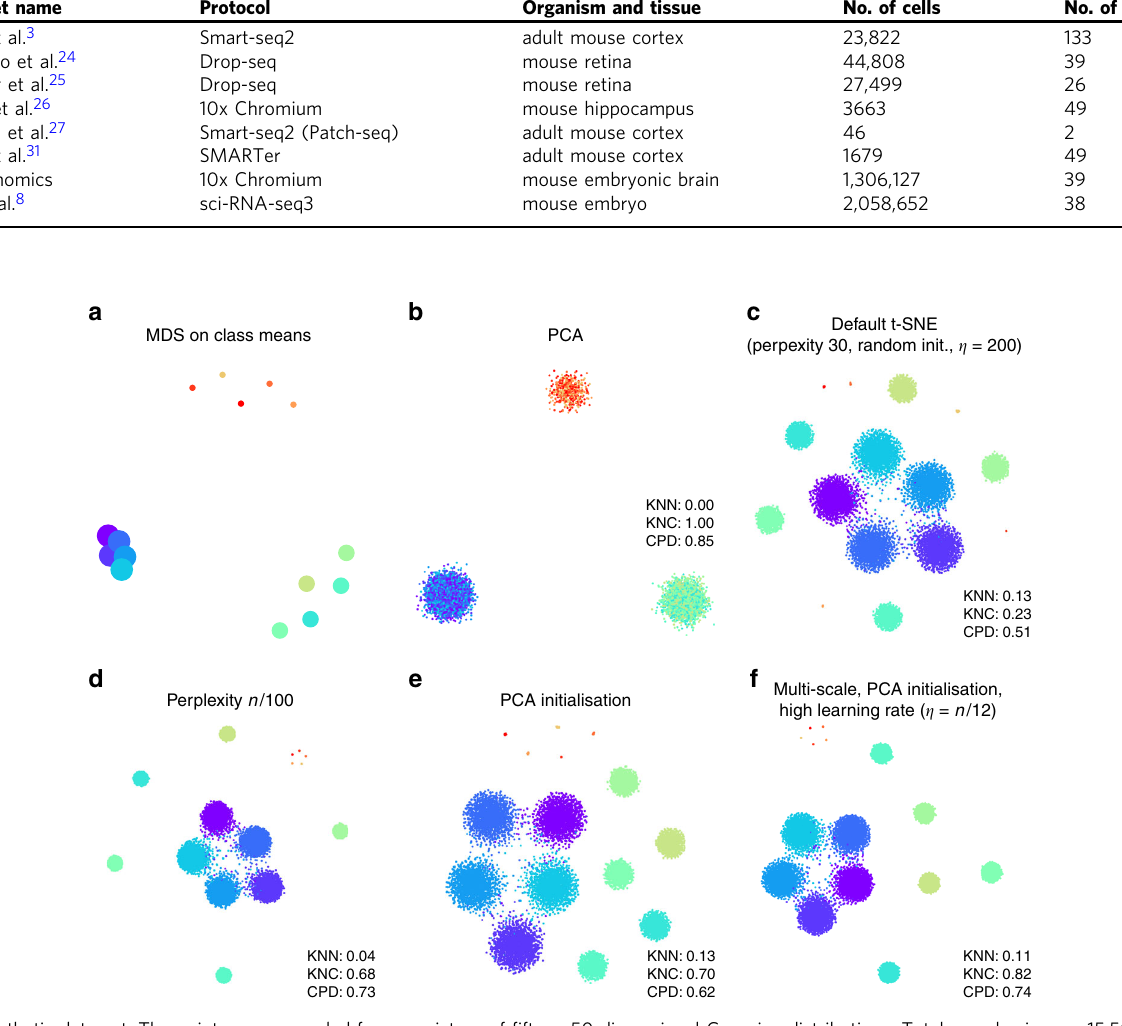
Fig. 1 Synthetic data set. The points were sampled from a mixture of fi fteen 50-dimensional Gaussian distributions. Total sample size n = 15,500. a Multidimensional scaling of 15 class means. Point sizes are proportional to the number of points per class. b The fi rst two principal components of the data. Point colours denote class membership. KNN: 10-nearest neighbour preservation, KNC: 4-nearest classes preservation, CPD: Spearman correlation between pairwise distances. c Default t-SNE with perplexity 30, random initialisation, and learning rate 200. d T-SNE with perplexity n = 100 ¼ 155. e T-SNE with PCA initialisation. f T-SNE with multi-scale similarities (perplexity combination of 30 and n = 100 ¼ 155), PCA initialisation, and learning rate n = 12 (cid:3) 1300.